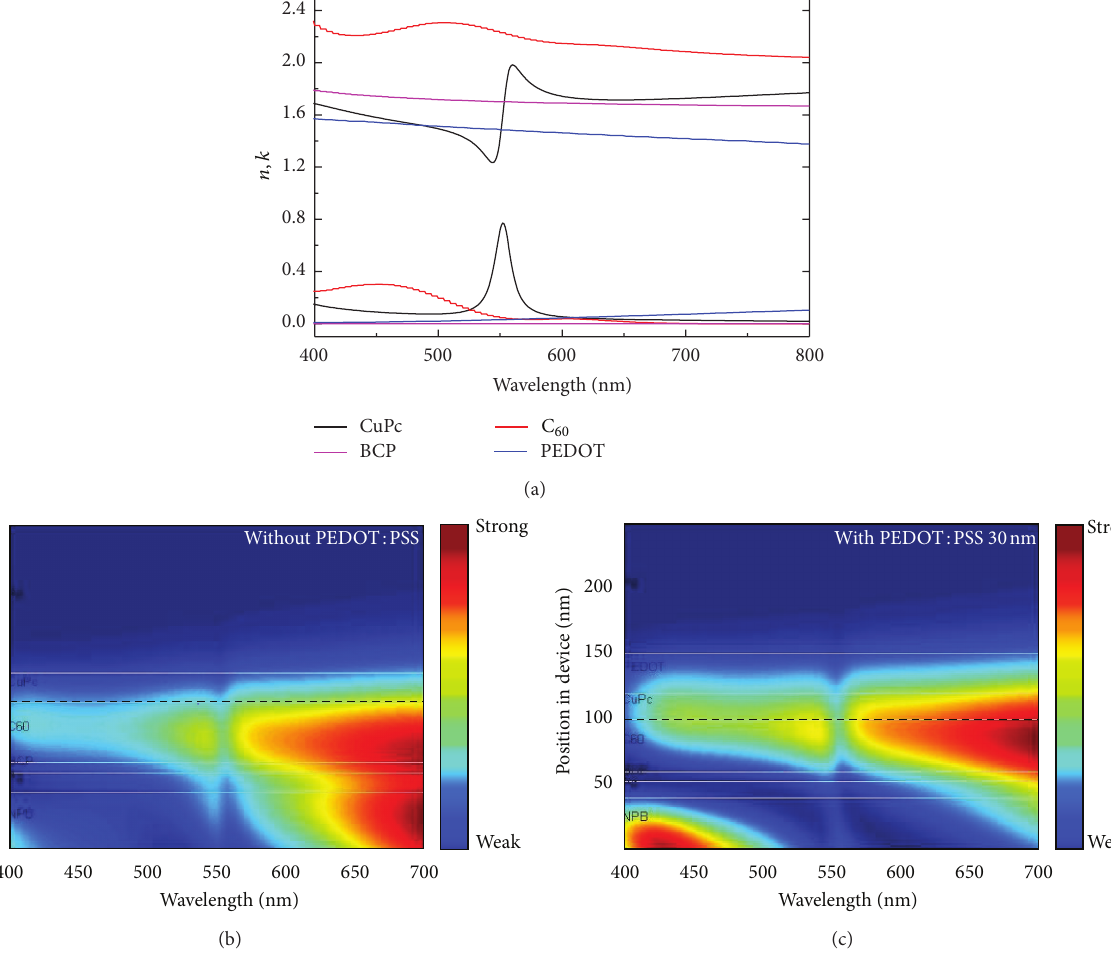
Figure 4: (a) Wavelength dependent refractive index ( 𝑛 ) and absorption coefficient ( 𝑘 ). Simulated optical field distribution inside TOPVs (b) with and (c) without 30 nm PEDOT:PSS